Question: Identify the chart type used in this figure.
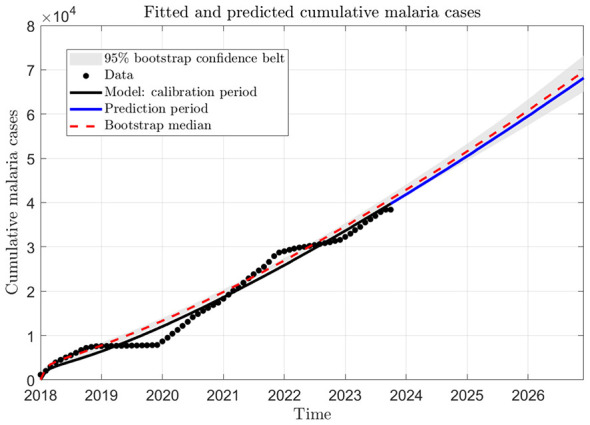
Answer: line